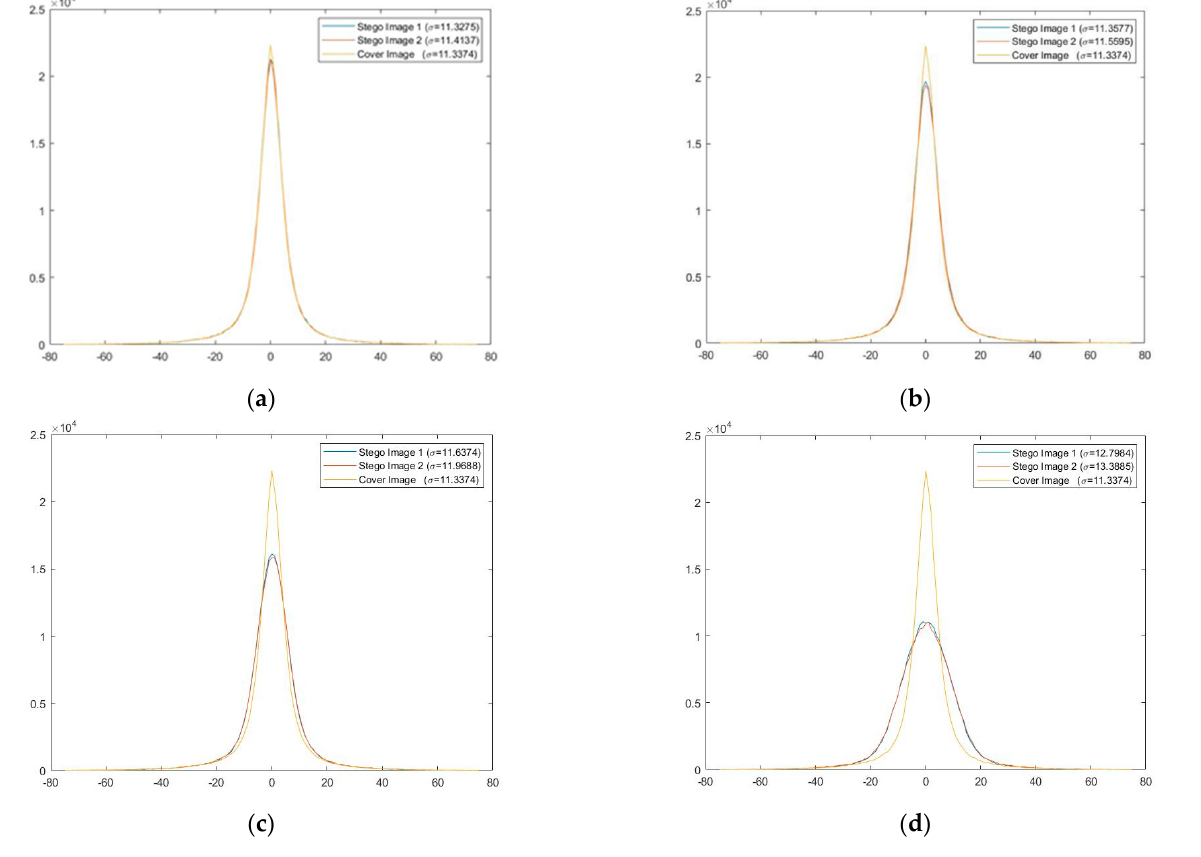
Figure 11. Comparisons of PDH analysis for n =1 to 4 in grayscale Lena image. ( a ) n = 1 ; ( b ) n = 2 ; ( c ) n = 3 ; ( d ) n = 4 .